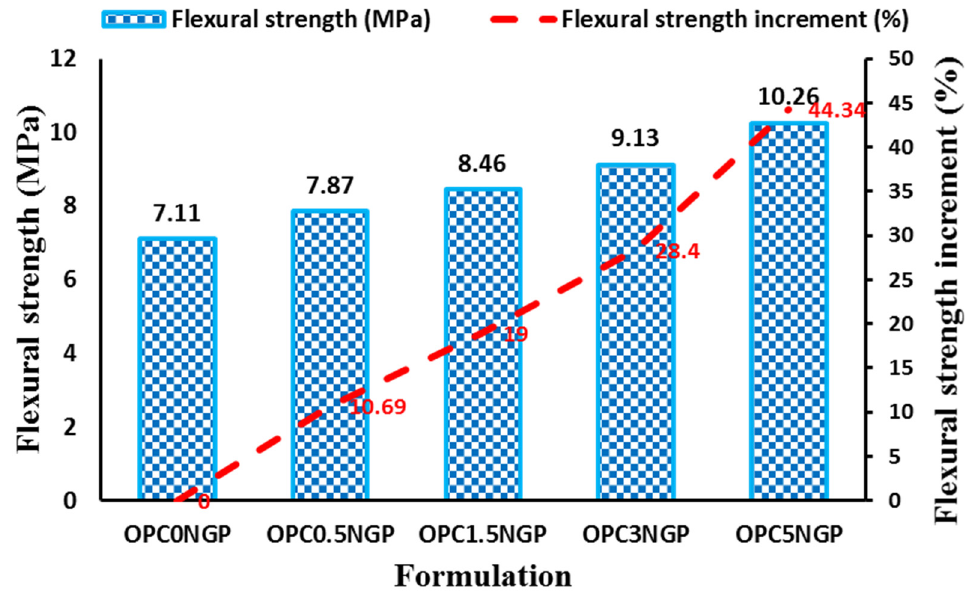
Figure 9. Influence of NGPs on flexural strength of concrete and percentage increase in flexural strength.